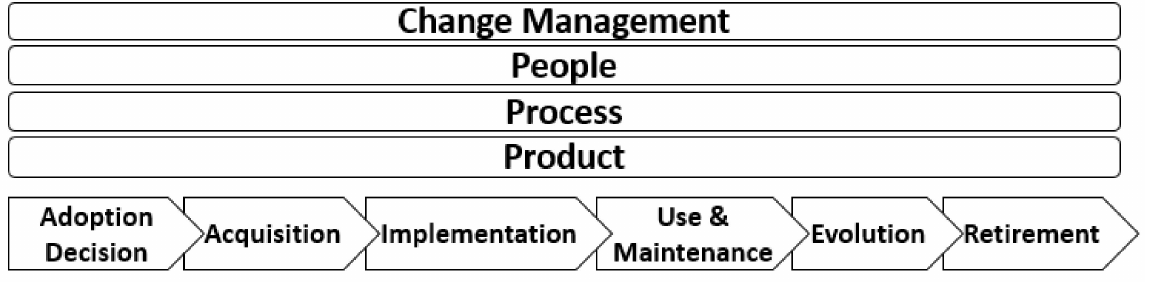
Figure 5. The ESs implementation lifecycle